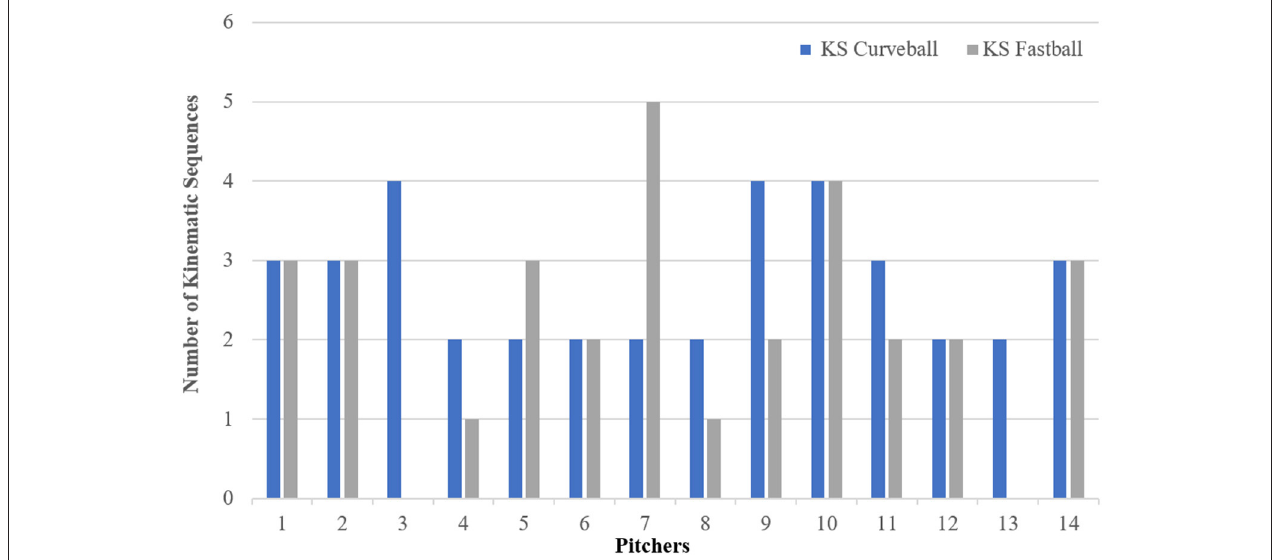
FIGURE 3 | The number of Kinematic Sequences performed across the 14 pitchers for Curveball and Fastball